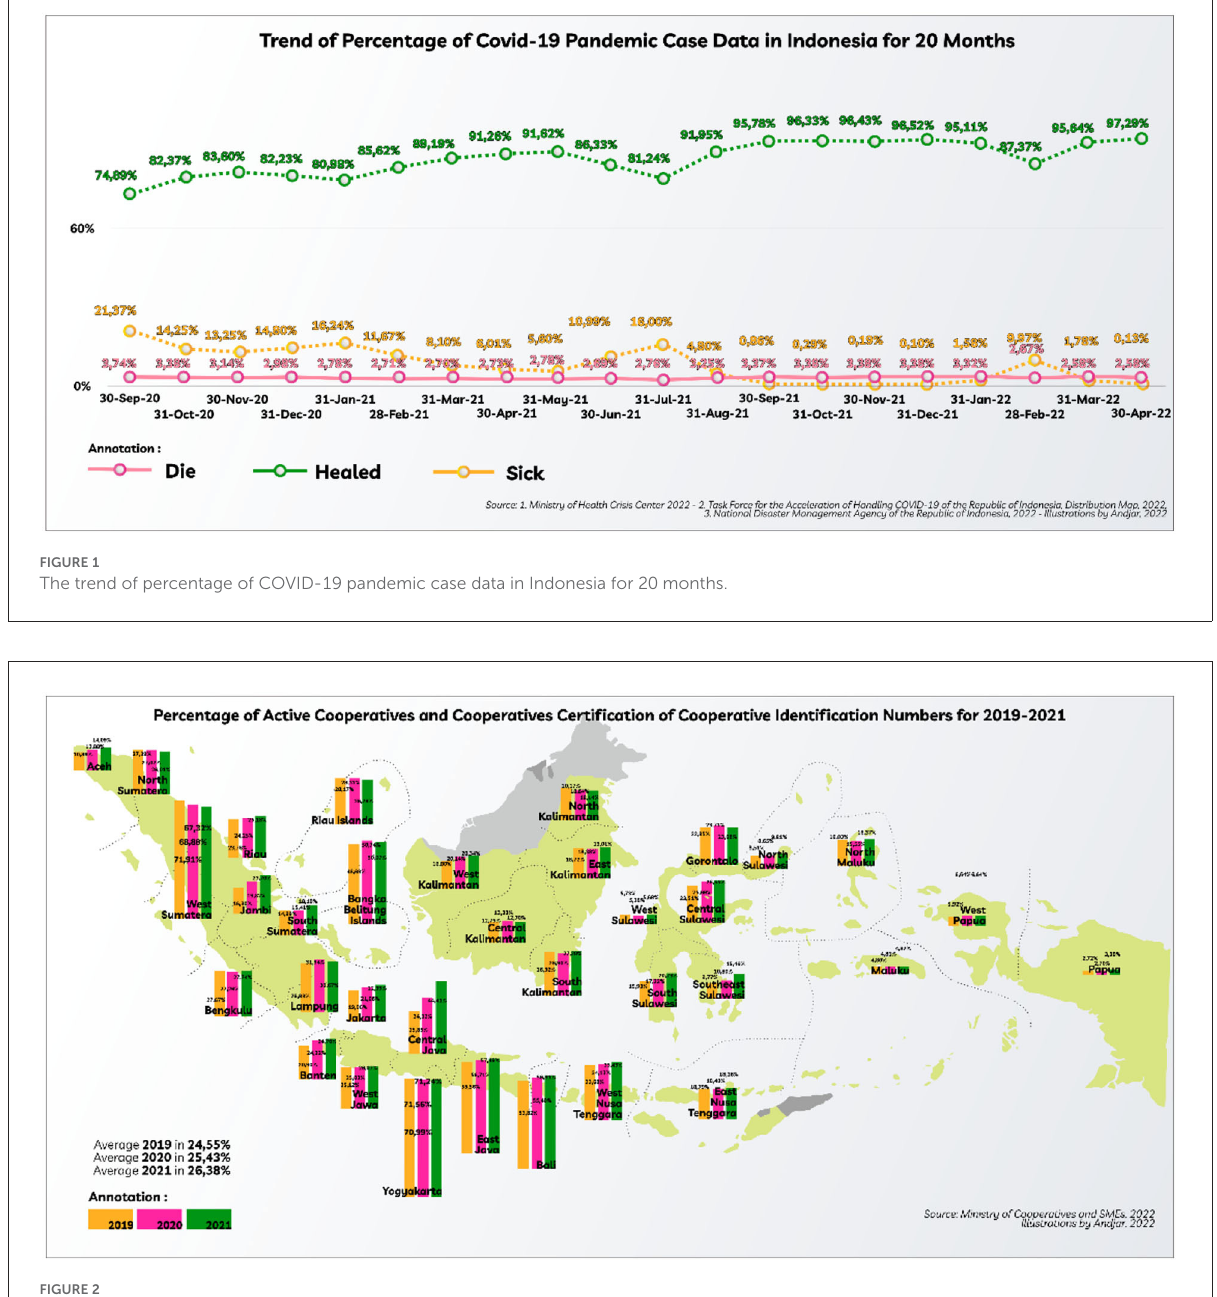
provinces that have cooperative members below five hundred thousand (refer to Figure